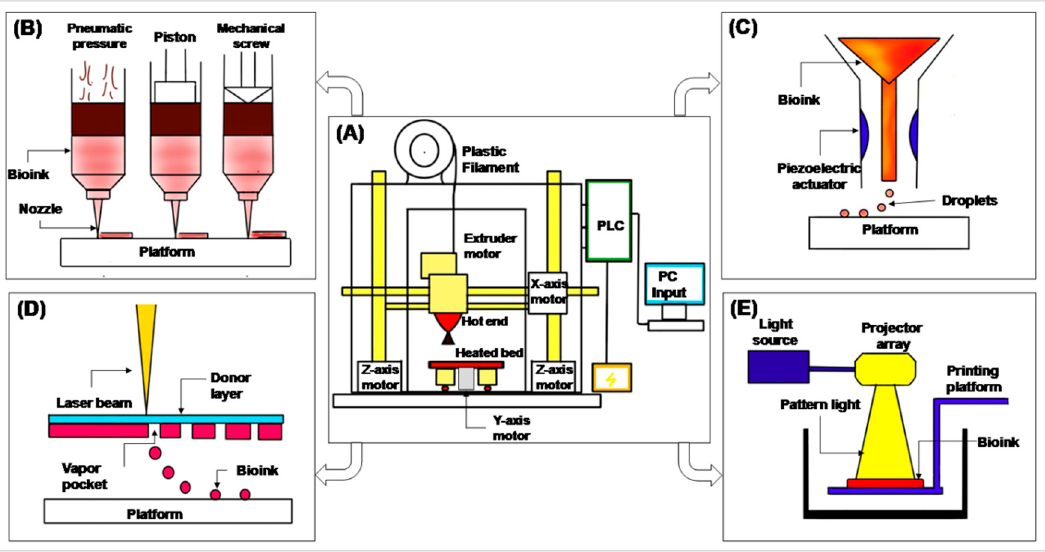
Figure 1. Schematic showing different 3D printing techniques. ( A ) General 3D printing apparatus. ( B ) Extrusion printer. ( C ) Inkjet printer. ( D ) Laser assisted printer. ( E ) Stereolithographic printer.